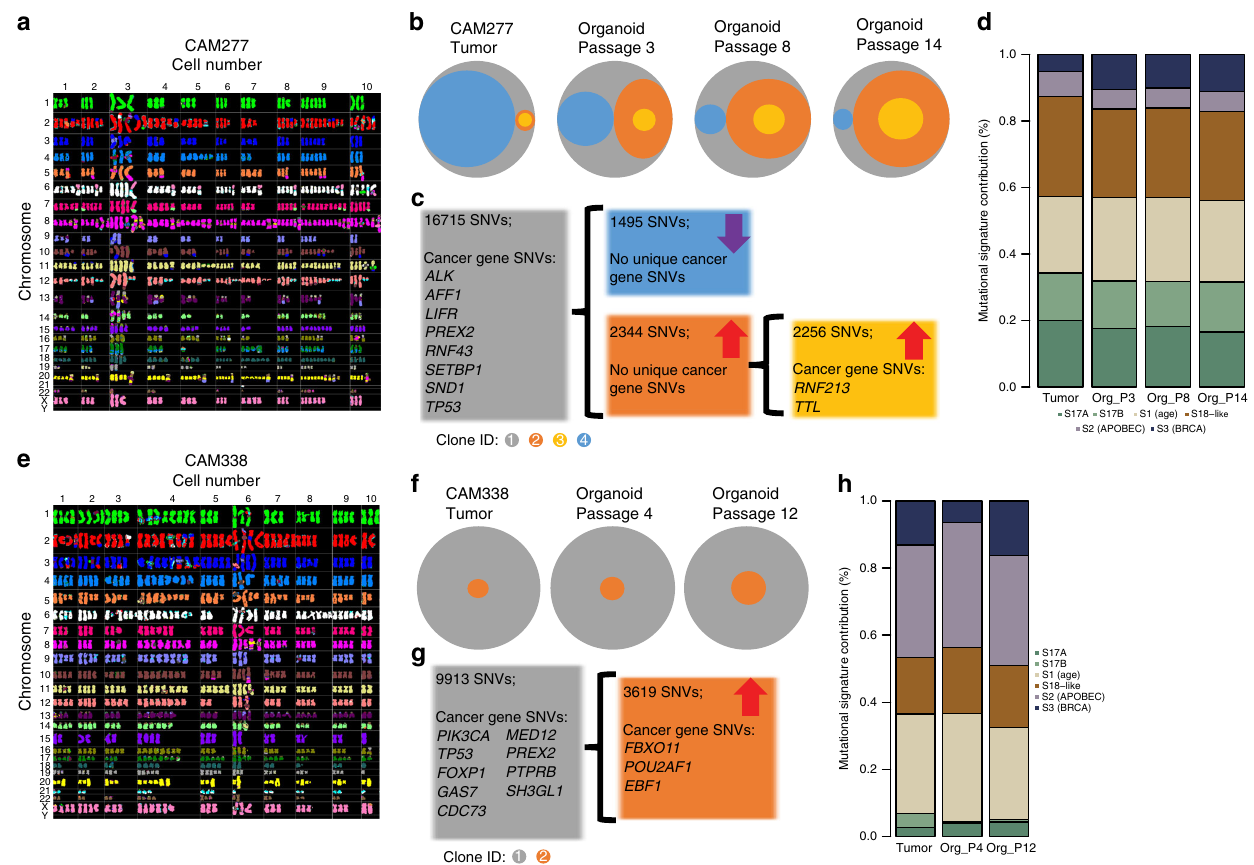
Fig. 5 EAC-derived organoids retain intra-tumor heterogeneity. M-FISH spectral karyotype of 10 cells from organoid culture of a CAM277 and e CAM388. Each chromosome has a unique color. Organoid cultures of b , c , d CAM277 and f , g , h CAM338 were continually cultured and sequenced at different passages to study clonal dynamics. b , f Segmented Venn diagram represents clonal composition of tumor cells at each time point. The compositions of each clone at different time points are listed in Supplementary Table 2. c , g Number of total mutations and mutated cancer-related genes from individual subclones. d , h The percentage contribution for each of the 6 mutational signatures across successive passages. The passage number is depicted